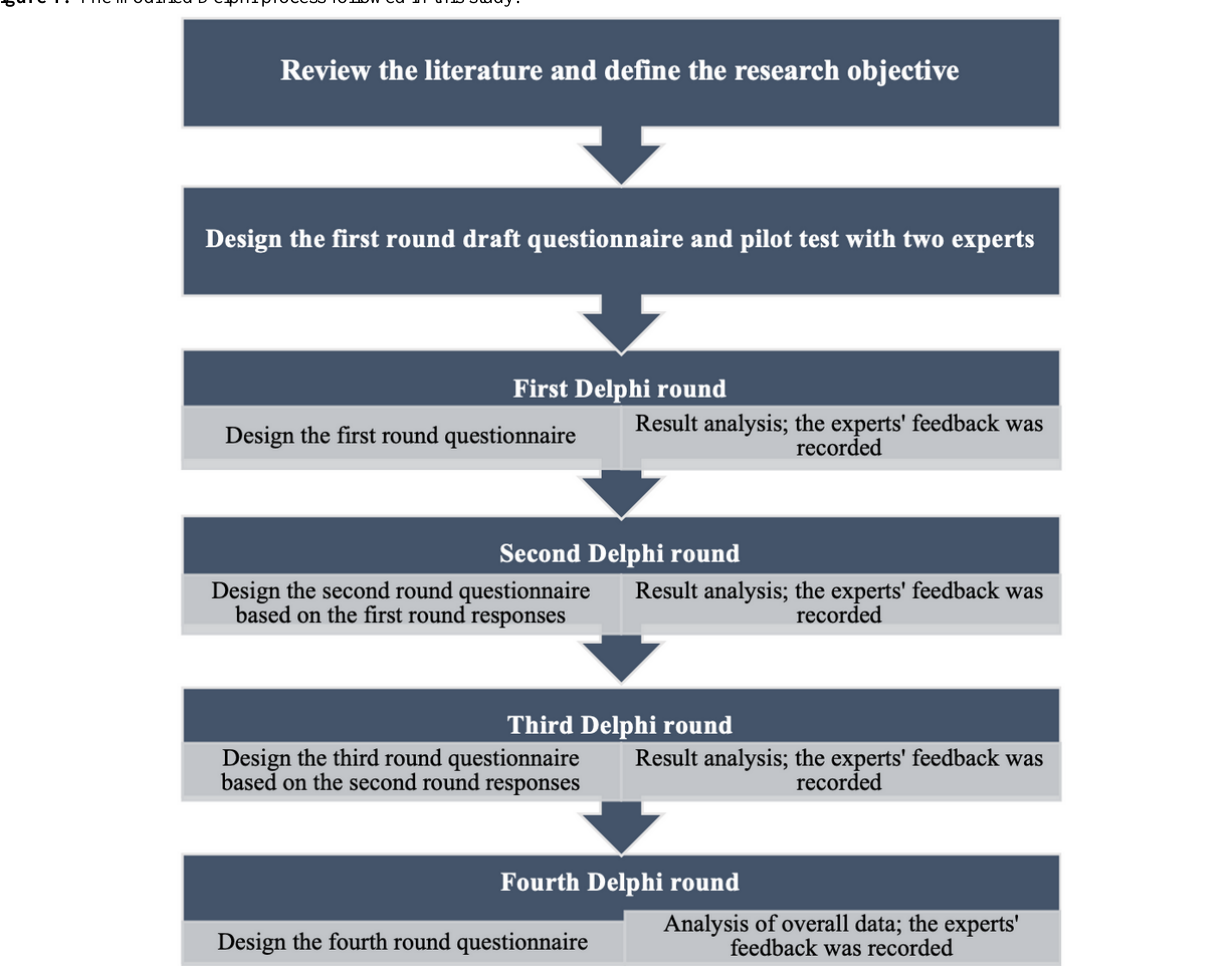
Figure 1. The modified Delphi process followed in this